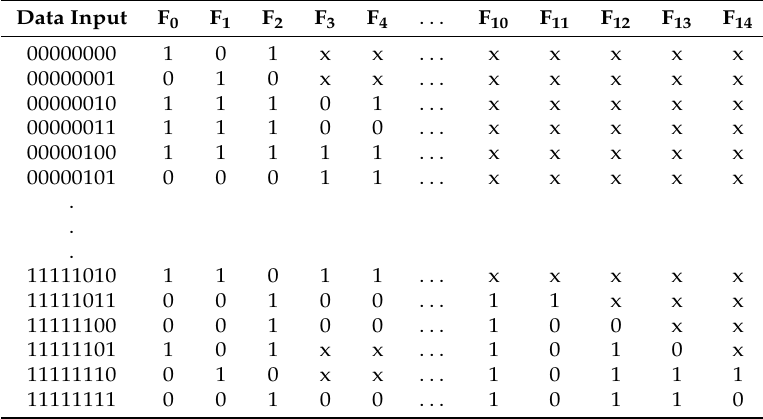
Table 4. Truth table of Red plane Huffman code